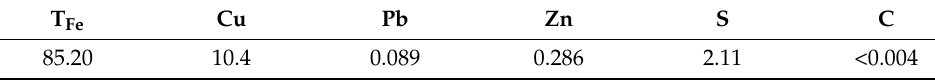
Figure 6. SEM analysis result of metal after separation. Table 3. Chemical composition of molten metal after separation (wt. %).